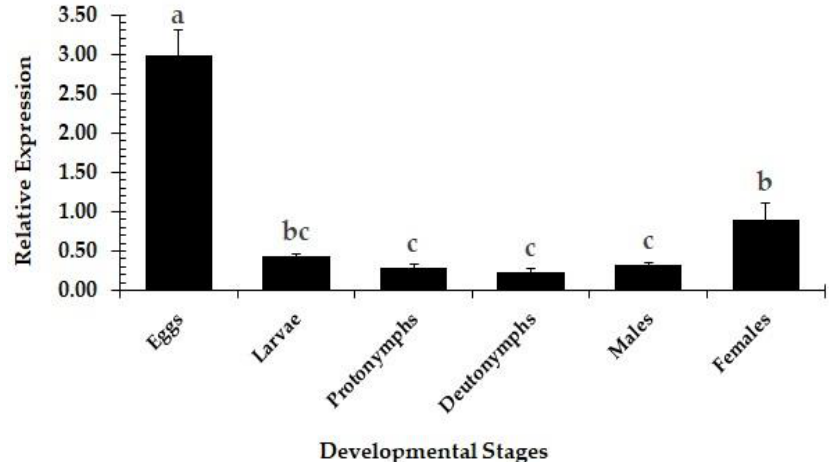
Figure 1. Relative expression patterns of the P. citri Chitin Synthase 1 ( PcCHS1 ) in different developmental stages. The treatment bars show the mean value of three independent replications ( n = 50 per replicate), while the error bars show the mean deviation. Different lower-case letter(s) above the bars indicate significant differences in the relative expression of the target gene (Tukey’s HSD test, α< 0.05). Different small case letters on the bars showing significant difference between the treatments.